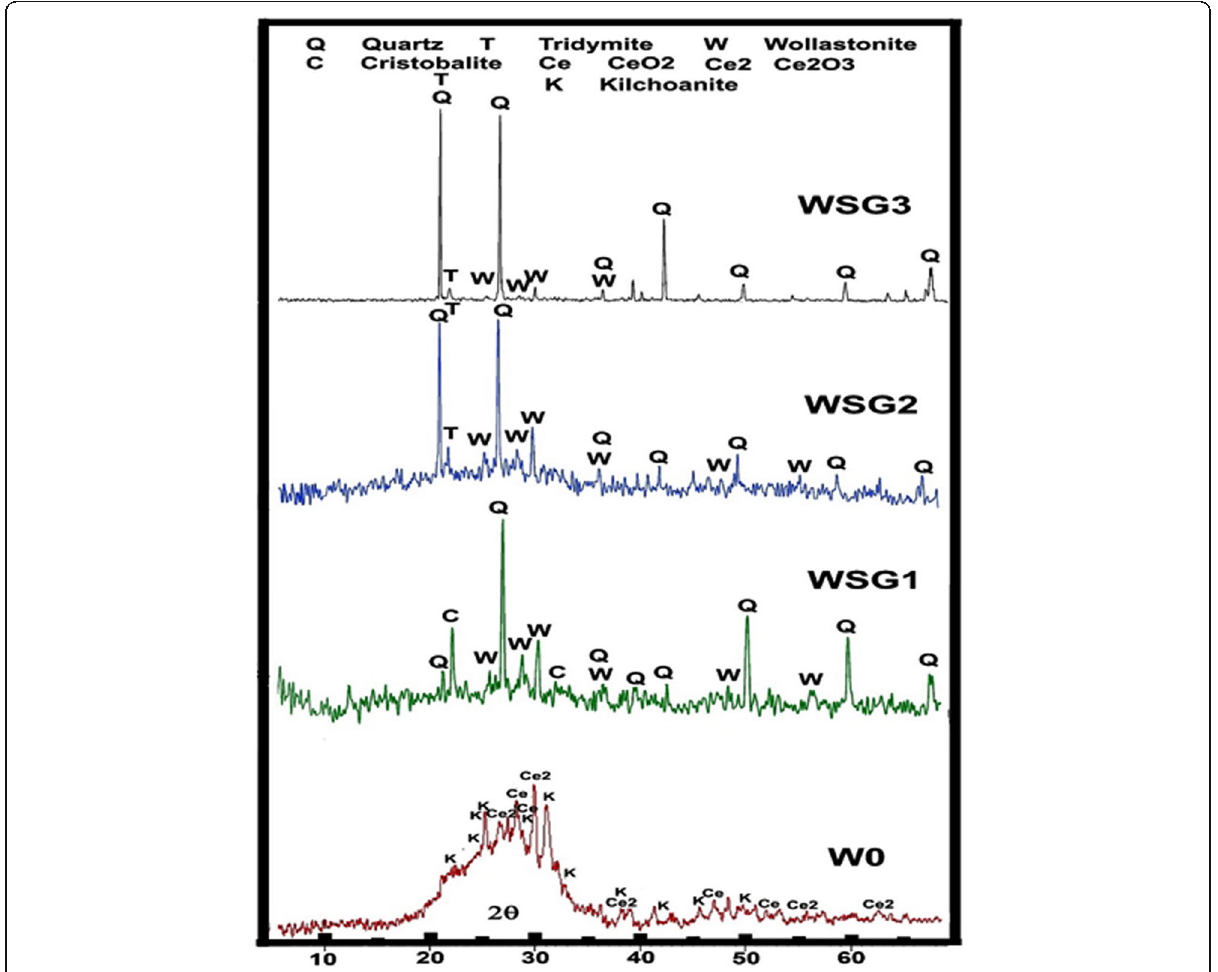
Fig. 2 X-ray diffraction pattern of dried Pb-containing waste W0 and the composite WSG1, WSG2, and WSG3 samples